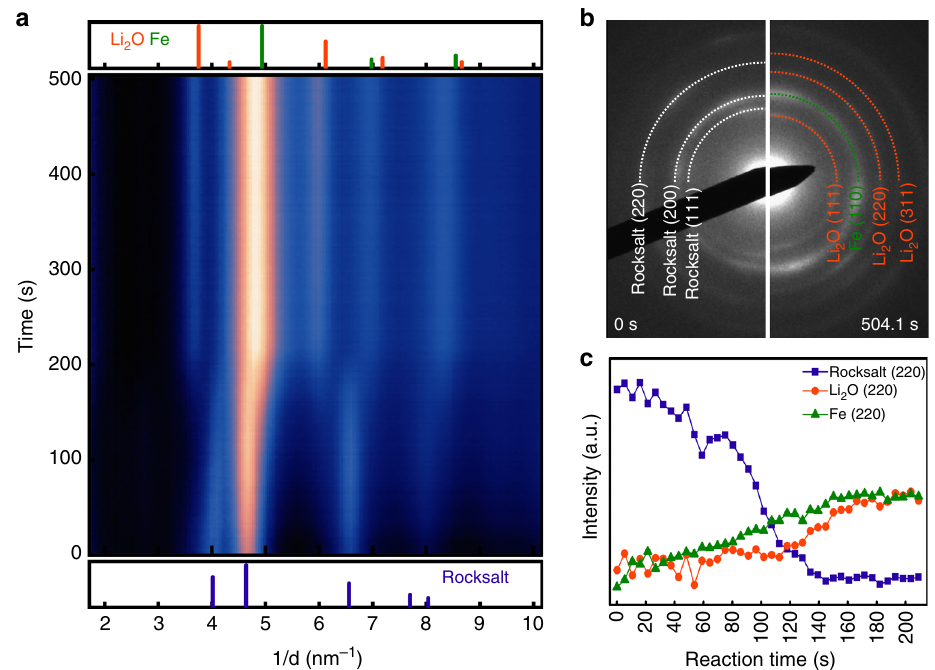
Fig. 3 In situ electron diffraction of Fe 3 O 4 − 3cy electrode during lithiation. a The radial integrated intensity pro fi les represent the phase evolution as a function of reaction time. Reference of corresponding phases (rock-salt, Li 2 O, and Fe) are, respectively, listed below and above the false color map. b SAED patterns obtained at pristine state (0 s, left panel) and fully lithiated state (504.1s, right panel), respectively. c Intensity pro fi les of Bragg re fl ections associated with rock-salt (220), Li 2 O (220), and Fe (220) change upon lithiation, showing the phase evolution between the rock-salt phase and metallic Fe as a function of reaction